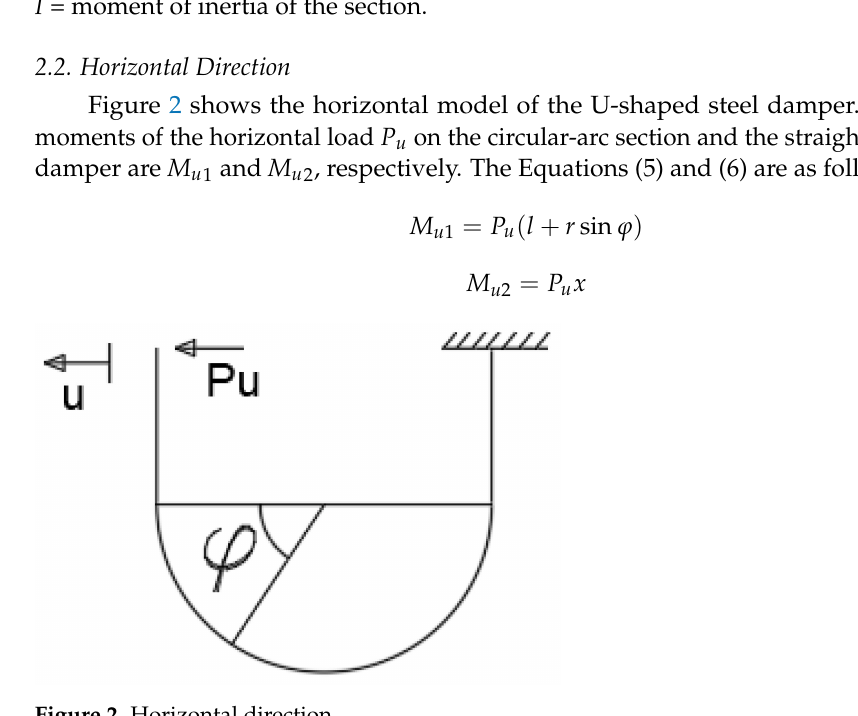
Figure 2. Horizontal